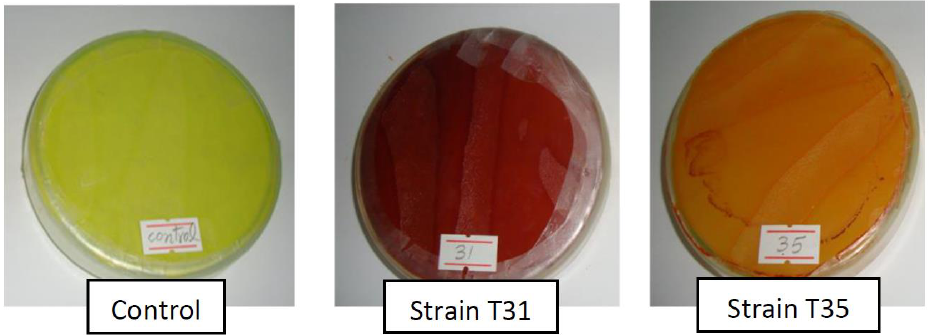
Figure 1. Pictorial view of cyanide production by rhizobacteria.